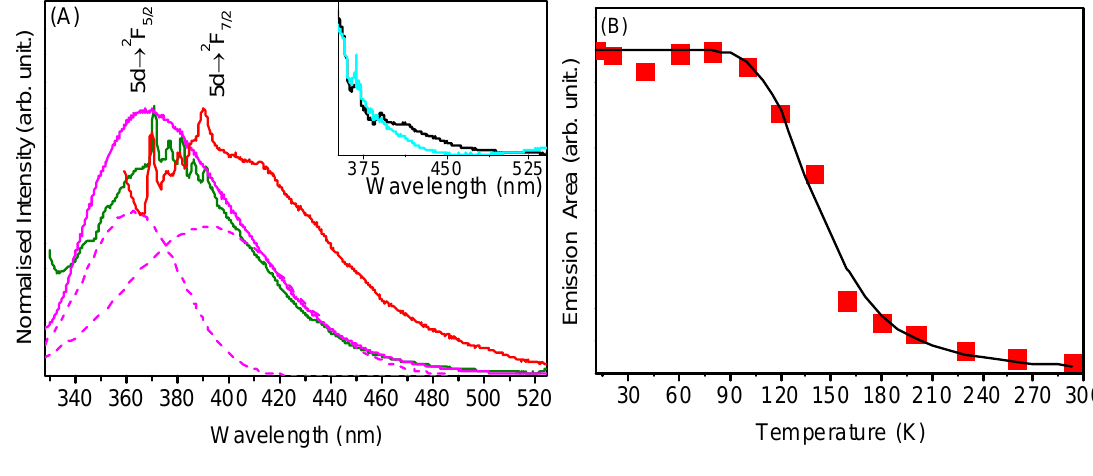
Figure 8. (A) 11 K emission spectra of CeNR (red), CeNR-PhEt-BuOOH (green) and CeNR-H O (magenta) excited at 316 nm: the dotted lines represent spectral deconvolution 2 2 using two Gaussian functions attributed to the 5d → 2 F emission spectra of CeNR (black) and CeNR600 (cyan) excited at 332 nm. (B) Emission intensity as a function of temperature of CeNR (red squares) and the Mott-Seitz fitting (solid line) using Equation.